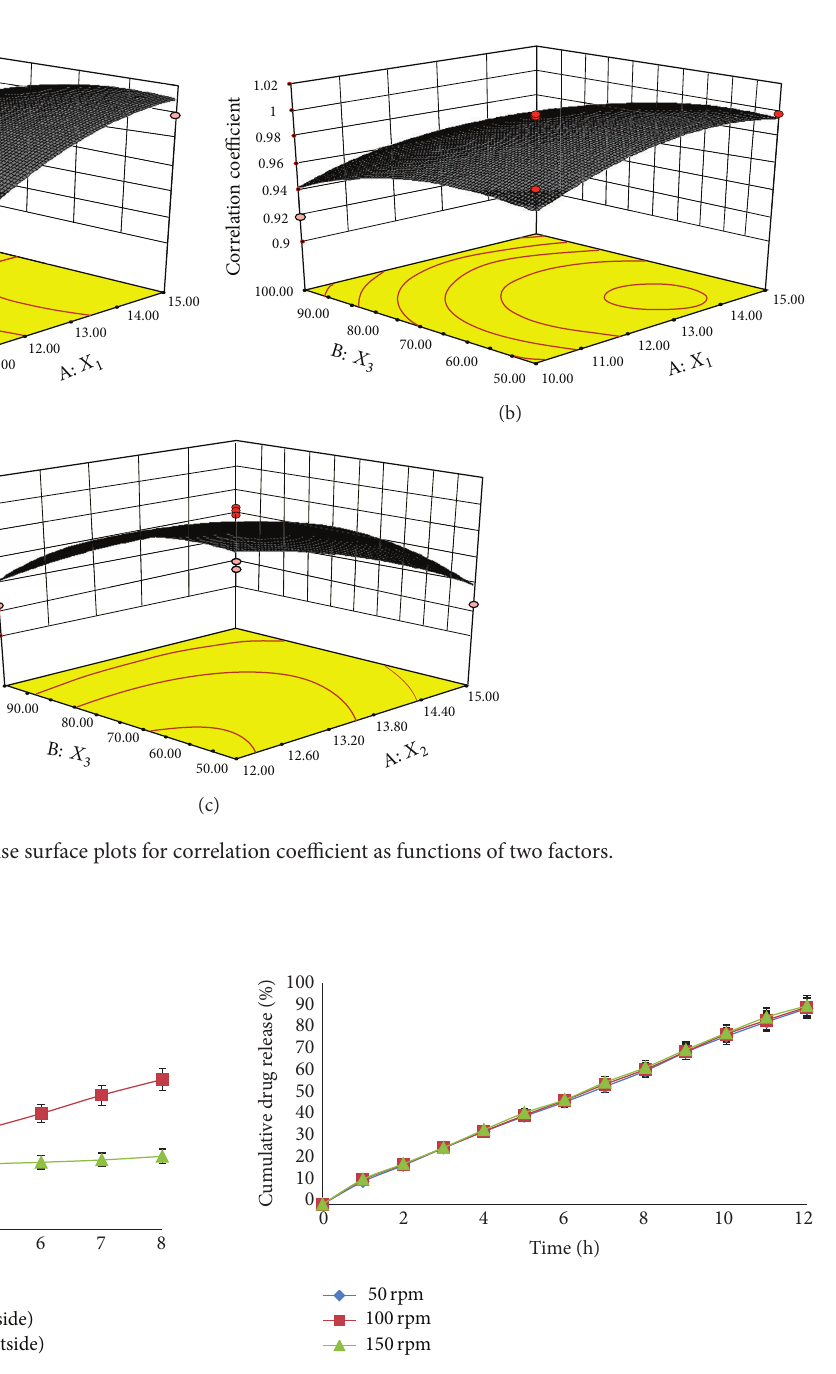
Figure 5: Comparative in vitro dissolution profiles showing effect of osmotic pressure.